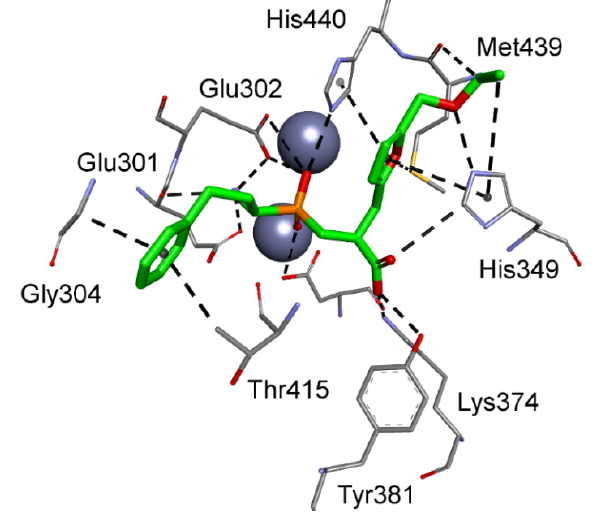
Figure 7. Modeled binding mode of a phosphinic dipeptide analog in the active center of aspartyl aminopeptidase (PDB: 4DYO) with the reverse orientation and a 5-(ethoxymethyl)furan-2-yl fragment (nominally P1 ′ ) extended to the S2 pocket.